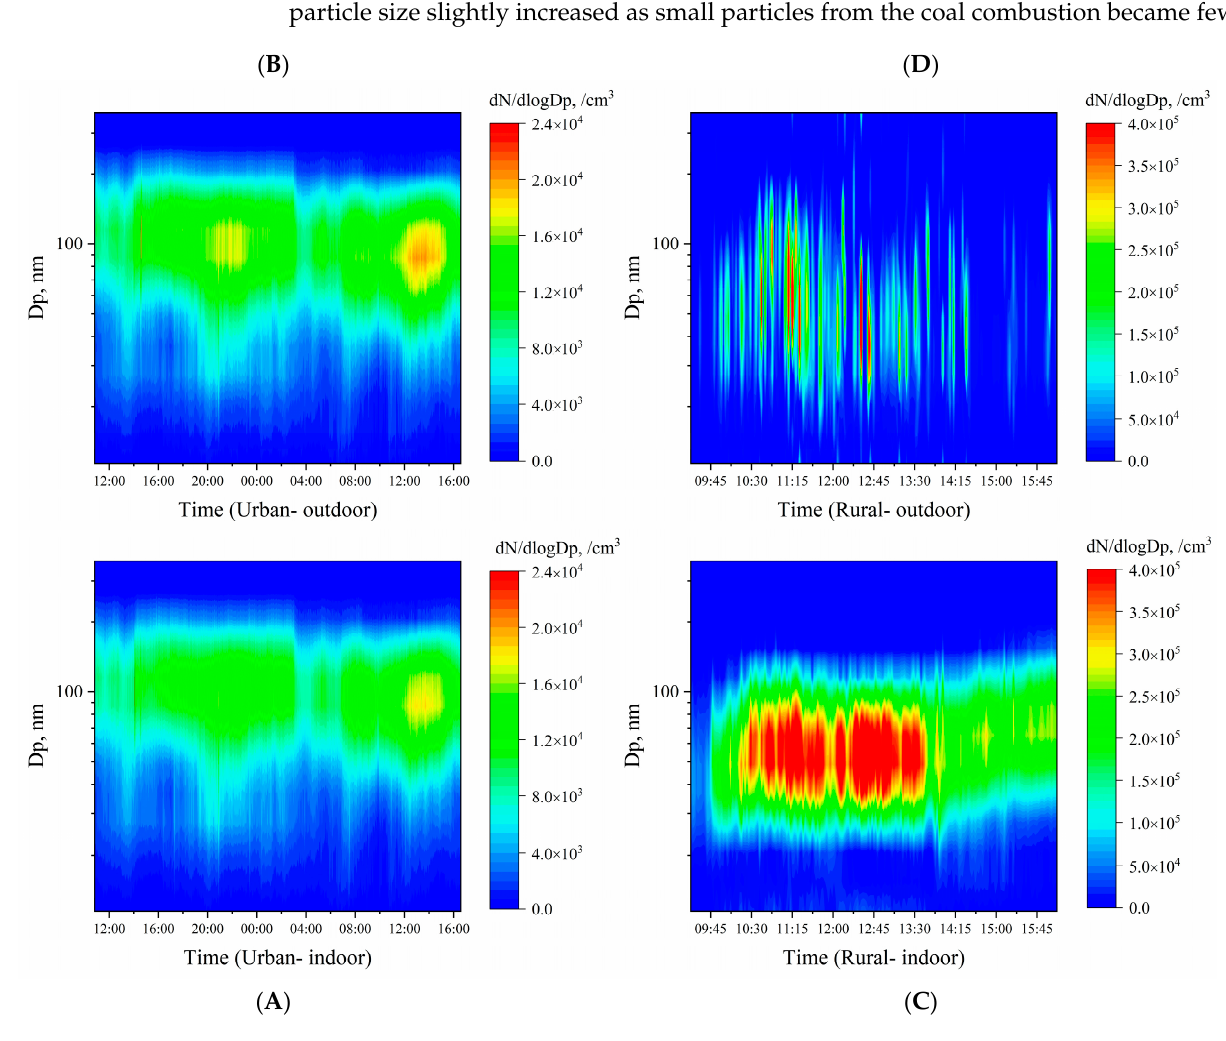
Figure 4. Dynamic changes and size distribution of UFP number concentrations in urban indoor ( A ) and outdoor ( B ), and rural indoor ( C ) and outdoor ( D )